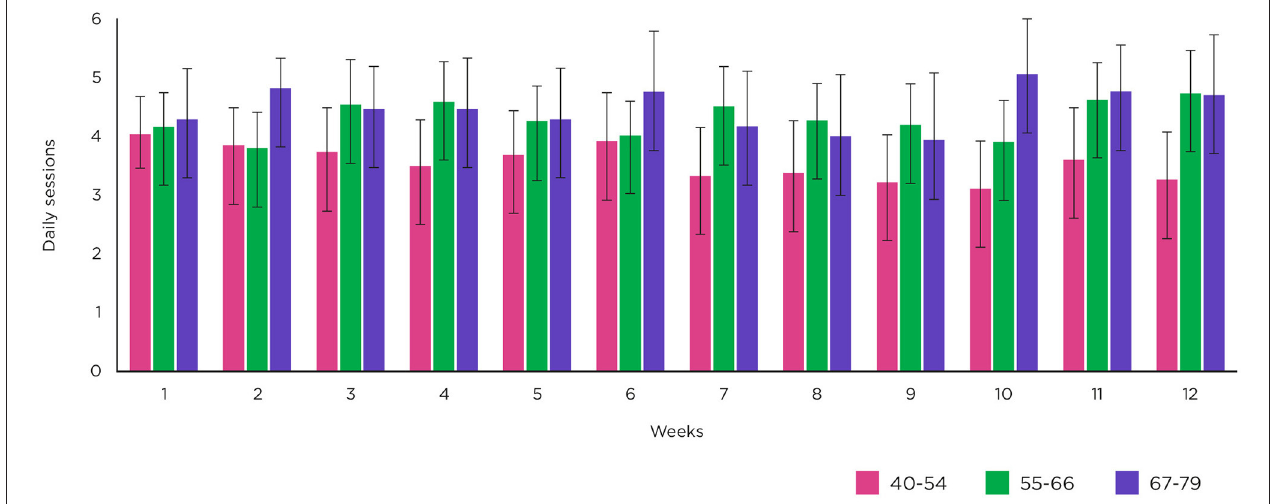
FIGURE 4 | Weekly adherence. Mean number of sessions per week across all participants and by age group. Error bars show upper and lower 95% confidence intervals.